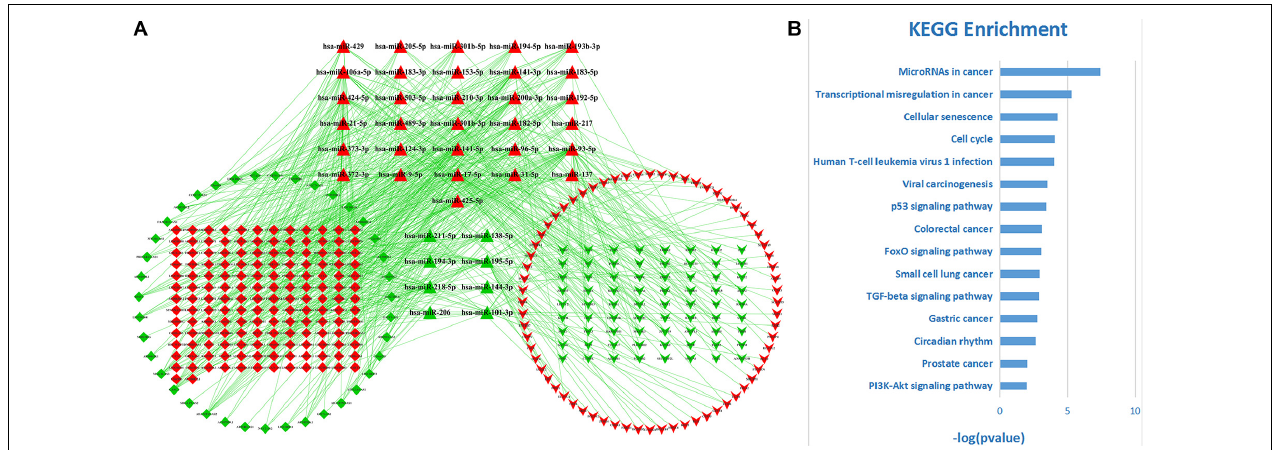
FIGURE 3 | The ceRNA network for LUAD and its functional involvements. (A) The topological structure of the ceRNA network for LUAD. Red nodes represent upregulation DE-RNAs and green ones downregulation DE-RNAs. Diamond, triangle, and inverse-triangle represent lncRNA, miRNA, and mRNA, respectively.